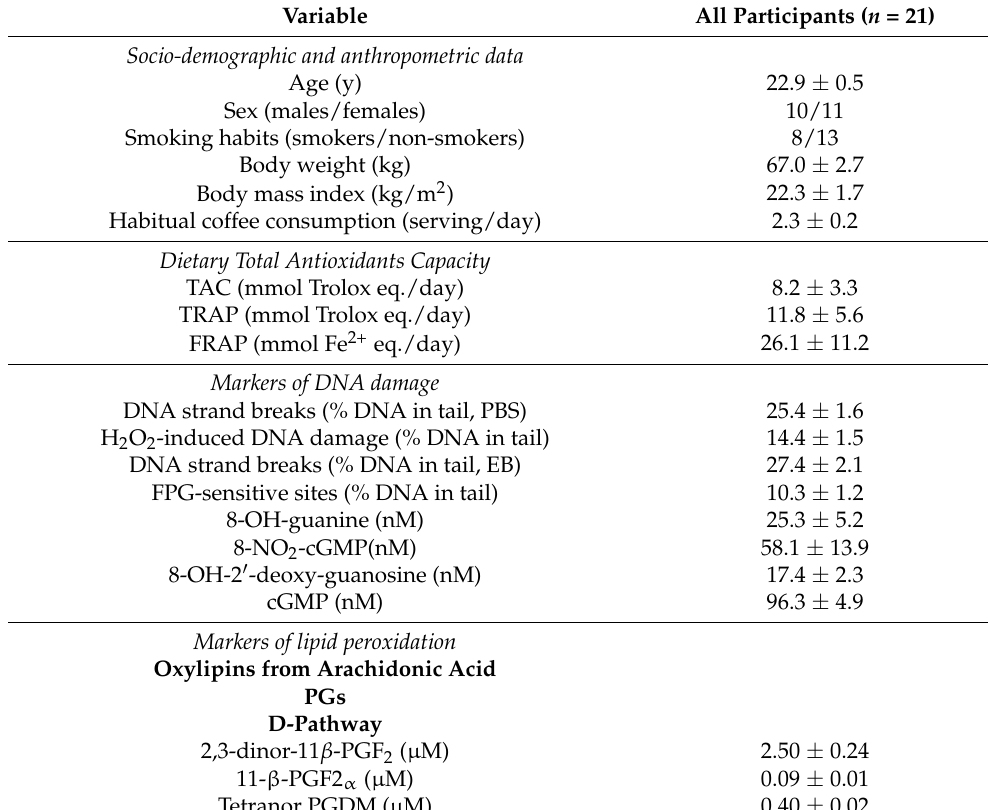
Table 1. Characteristics of subjects at